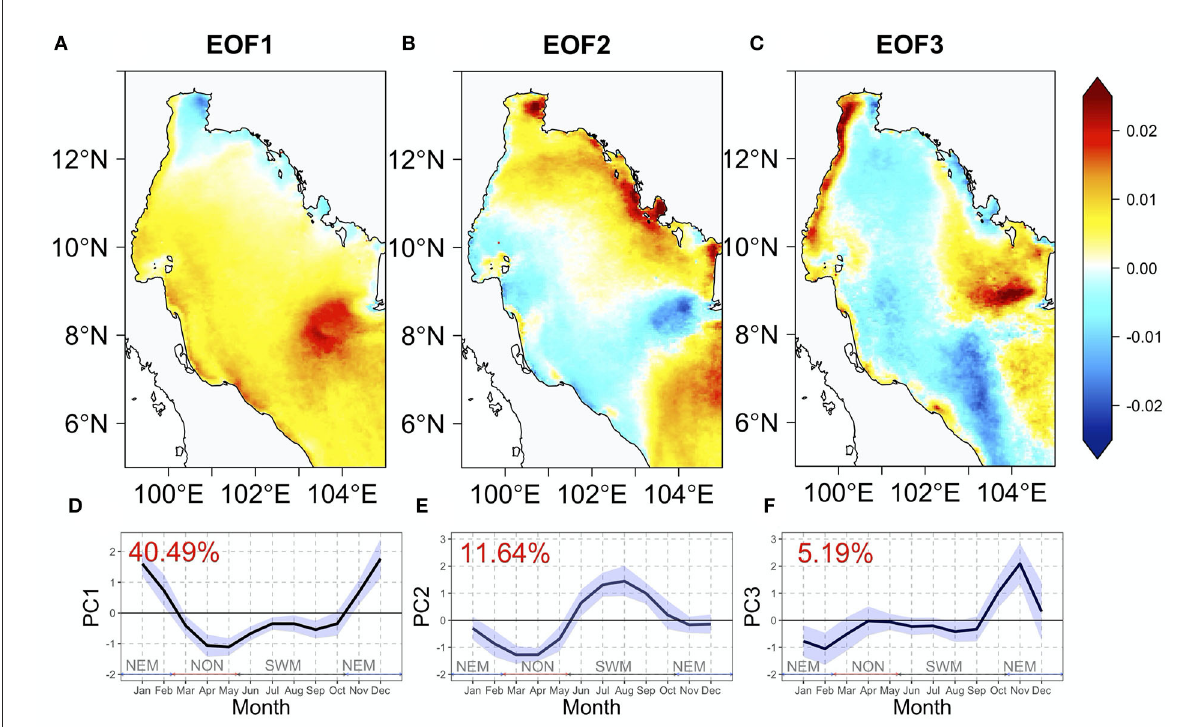
FIGURE4 Spatial pattern of EOFs (A–C) and PCs monthly composite (D–F) of the first three modes for chl-a. The black lines and shaded areas in (D–F) indicate monthly means and standard deviations, respectively, of the PC time series from 2002 to